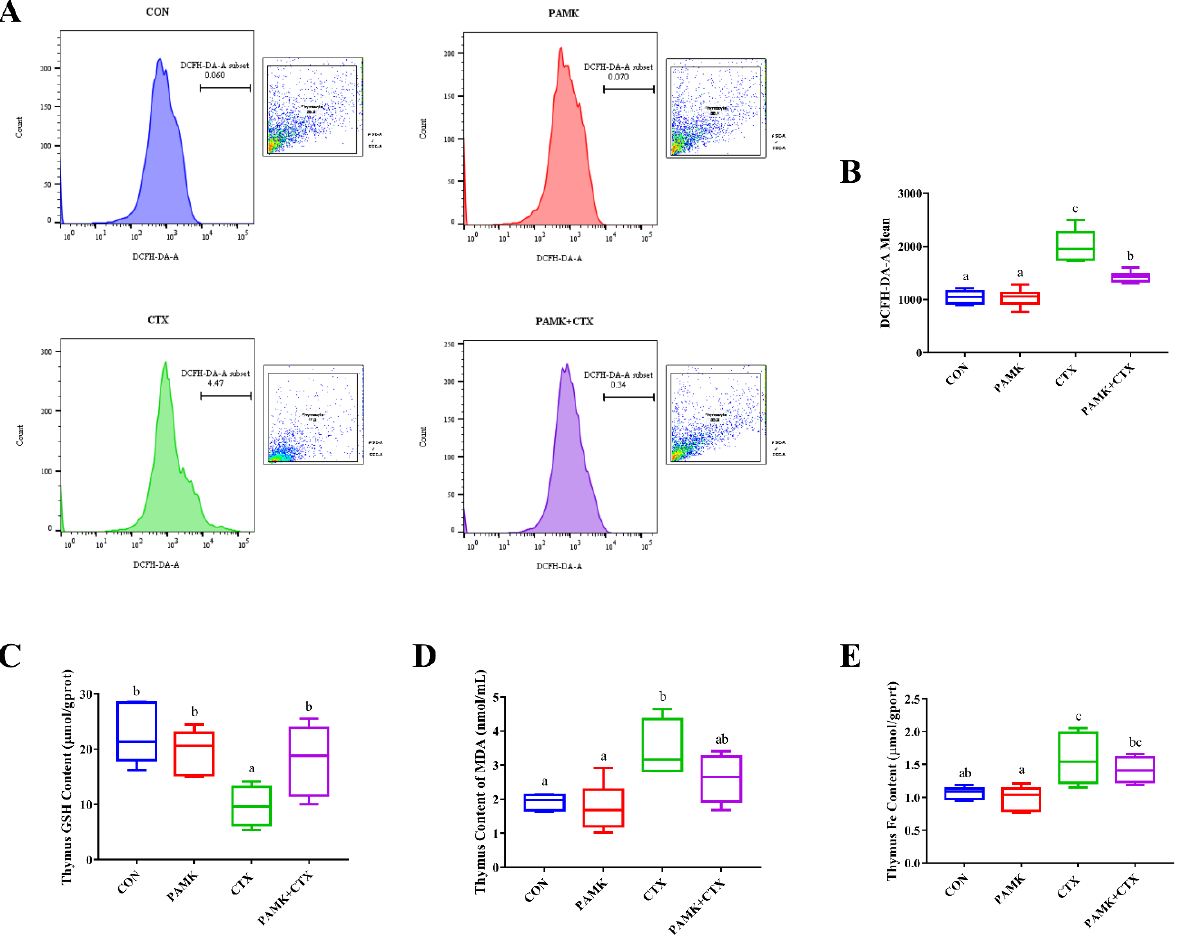
Figure 5. Effects of PAMK on levels of oxidative stress and iron content in thymus treated with CTX. ( A ) DCFH-DA staining to detect lipid ROS in the thymus. Mean fluorescence intensity was measured by flow cytometry; ( B ) ROS level; ( C ) GSH content; ( D ) MDA content; ( E ) iron content. Data are expressed as min to max, n = 10. Different letters indicate p < 0.05, significantly different.